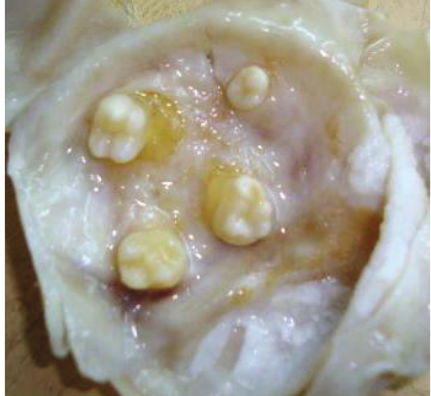
Figure 1: Gross specimen revealing the presence of molariform teeth.